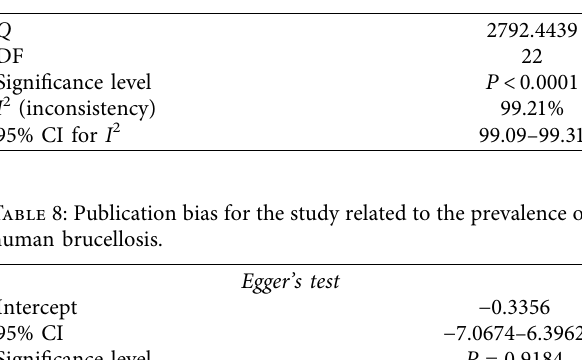
Table 7: Test for heterogeneity for the prevalence of human brucellosis.